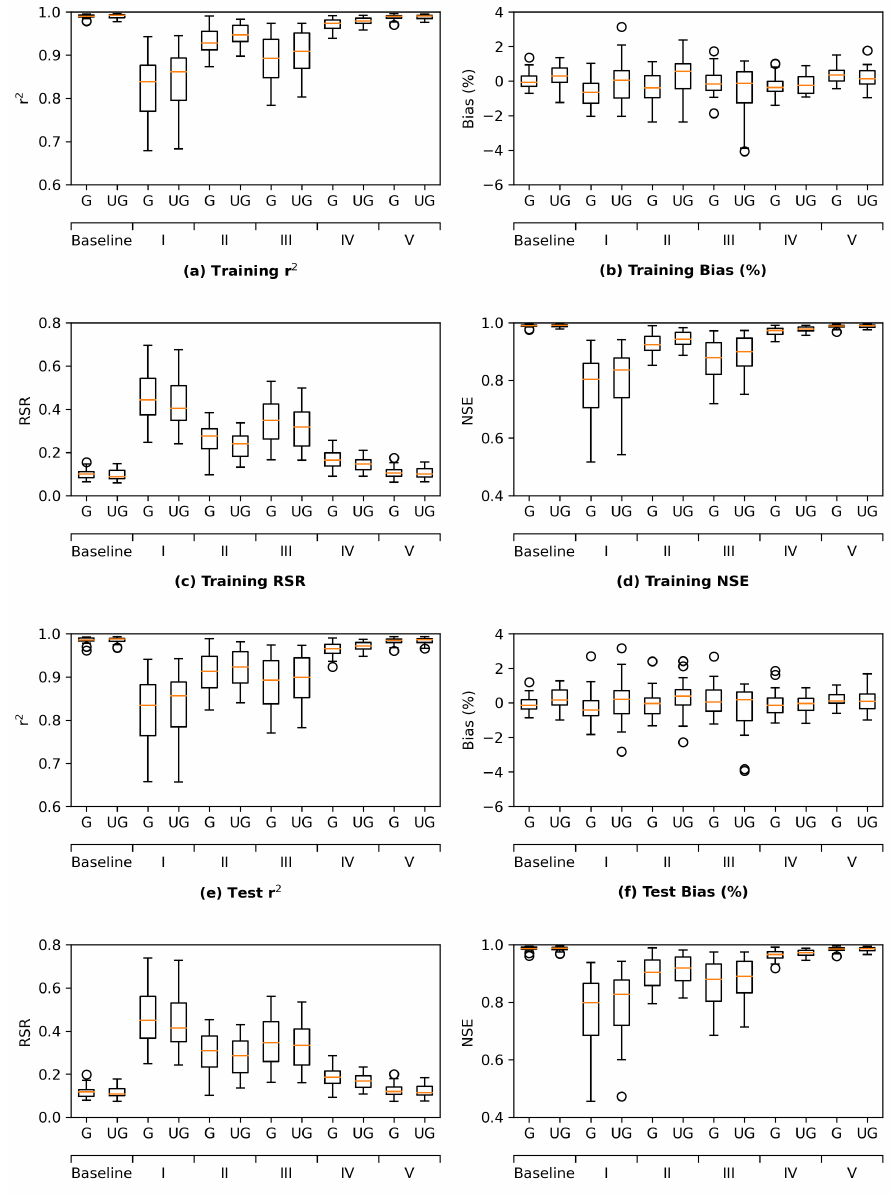
Figure 6. Box and whisker plots of four types of metrics consisting of r 2 , percent bias, RSR, and NSE during the training (panels ( a – d )) and test (panels ( e – h )) phases of the grouped (G) and ungrouped (UG) MLP models under six scenarios: baseline and five different memory lengths as presented in Table 1. For a specific plot, the orange line represents the median value of the 28 metrics corresponding to 28 study locations; the box containing the orange line is the interquartile range from the 25th percentile up to the 75th percentile. The top bar designates the maximum metric value within 1.5 times the interquartile range above the 75th per percentile, while the bottom bar represents the minimum metric values within 1.5 times the interquartile range below the 25th percentile. The open circles designate